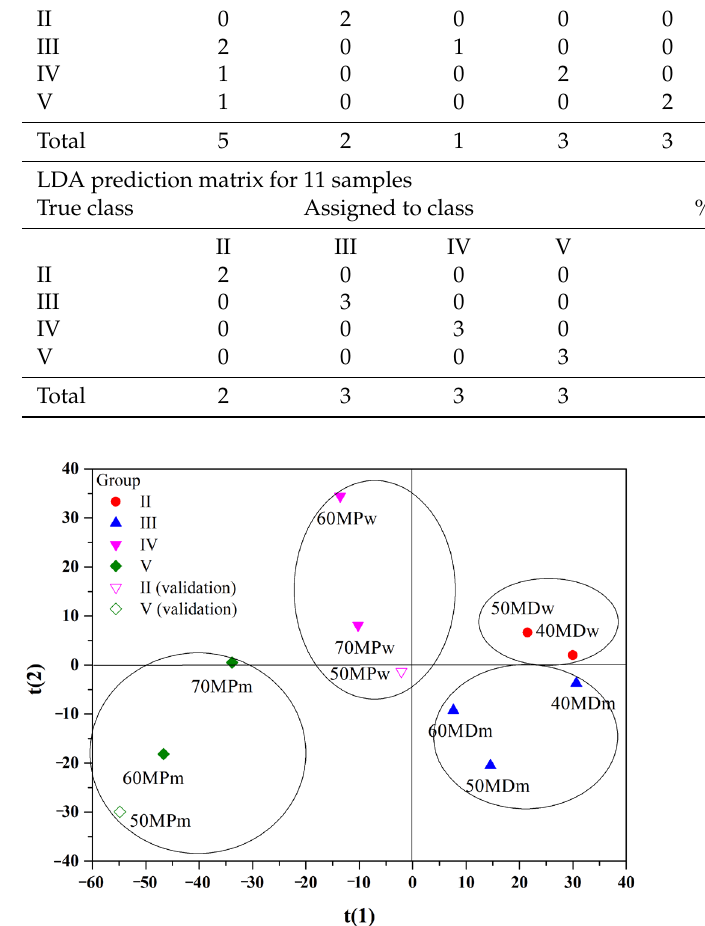
Figure 5. Partial least-squares-discriminant analysis (PLS-DA) scores plot t(1)/t(2) of FTIR spectra on the range 1800–750 cm − 1 .